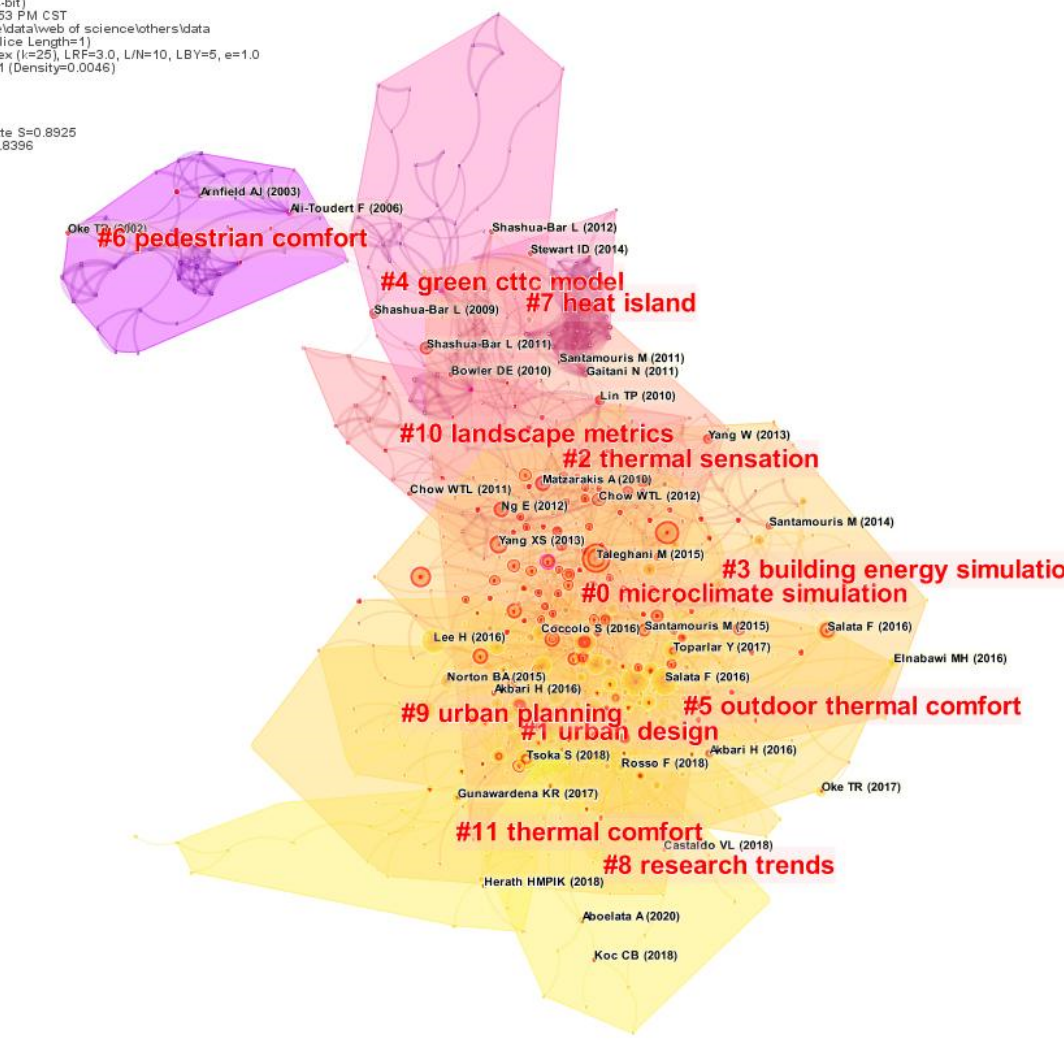
Figure 6. Mapping of co ‐ cited studies in the landscape microclimate research literature.